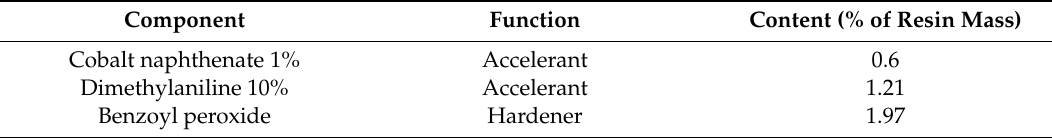
Table 2. Three-component curing system for vinyl ester resin used in tested mix